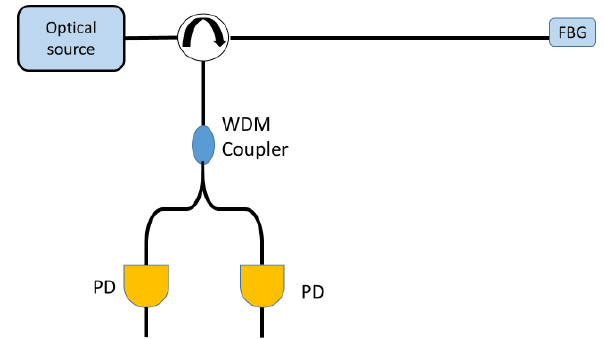
Figure 16. Example of an experimental set-up for passive wavelength division multiplexer coupler filtering interrogation technique.